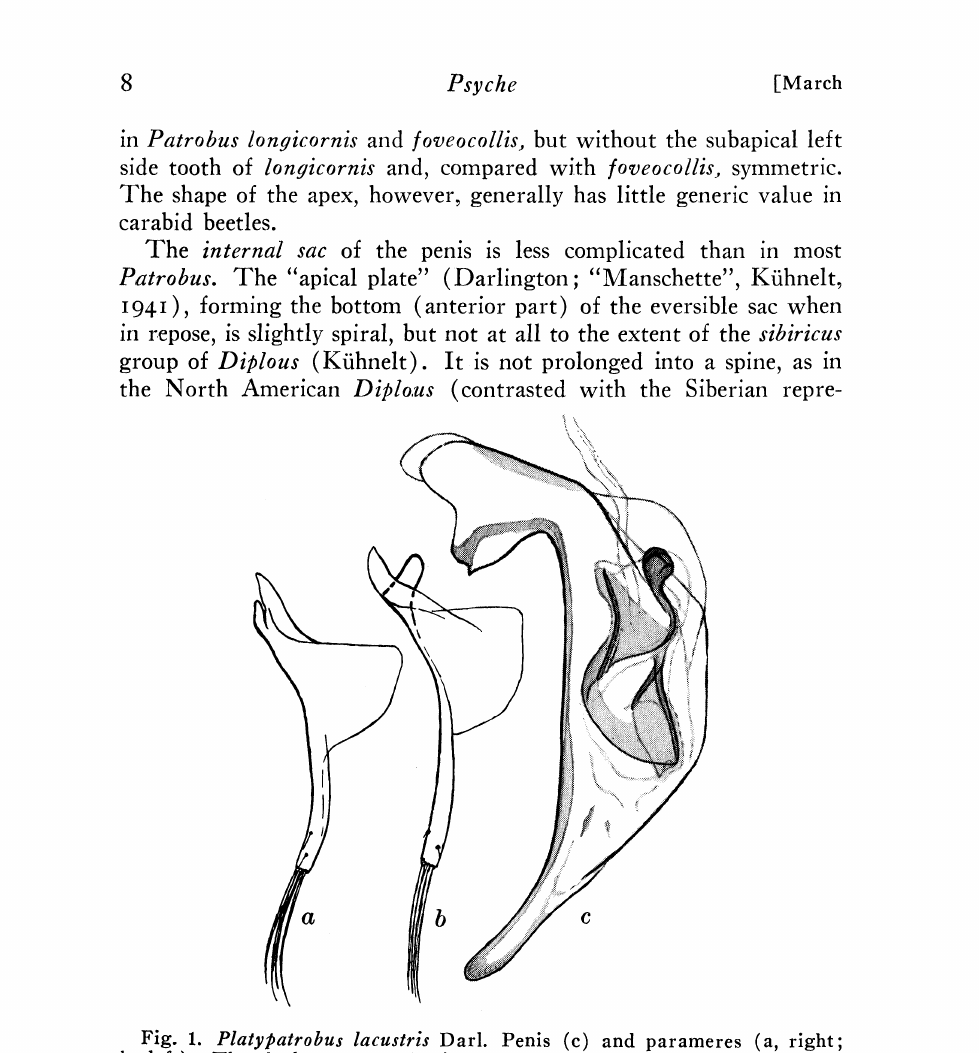
Fig. 1. Platylatrobus lacustris Darl. Penis (e) and parameres (a, right; b, left). The dark parts of the internal sac are not isolated selerites but thickened margins of